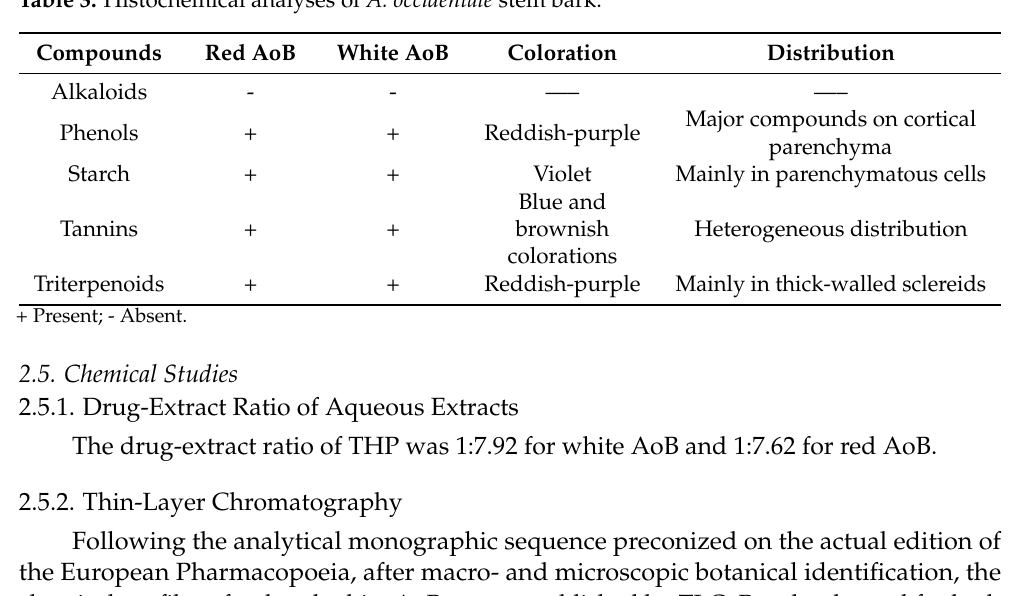
Table 3. Histochemical analyses of A. occidentale stem